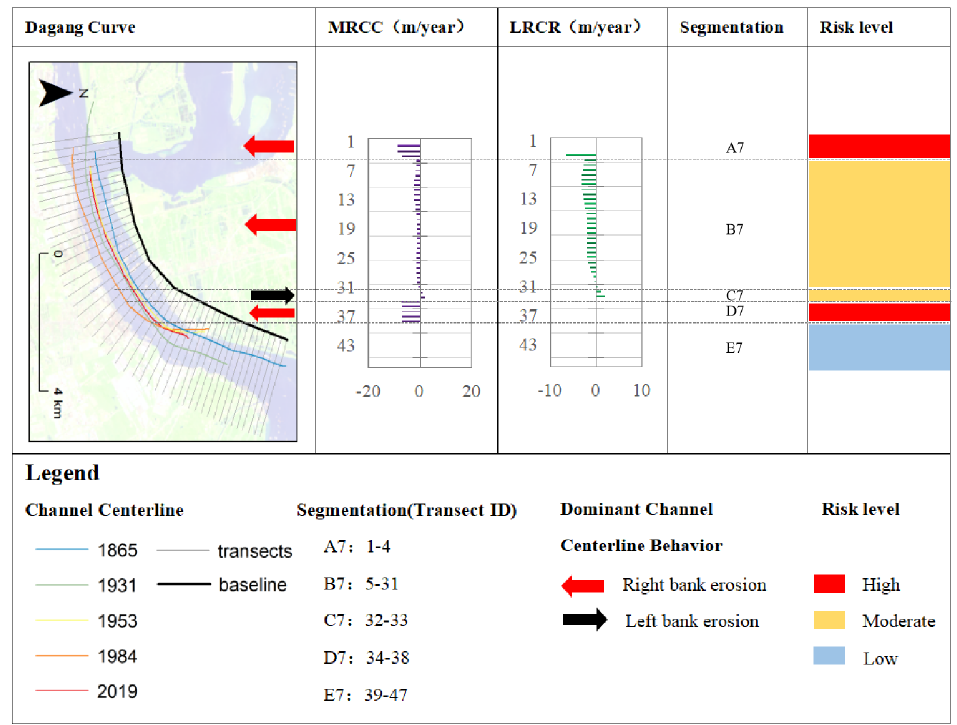
Figure 11. The Migration Rate of Channel Centerline, Linear Regression Change Rate, and erosion risk identification on Dagang Curve.